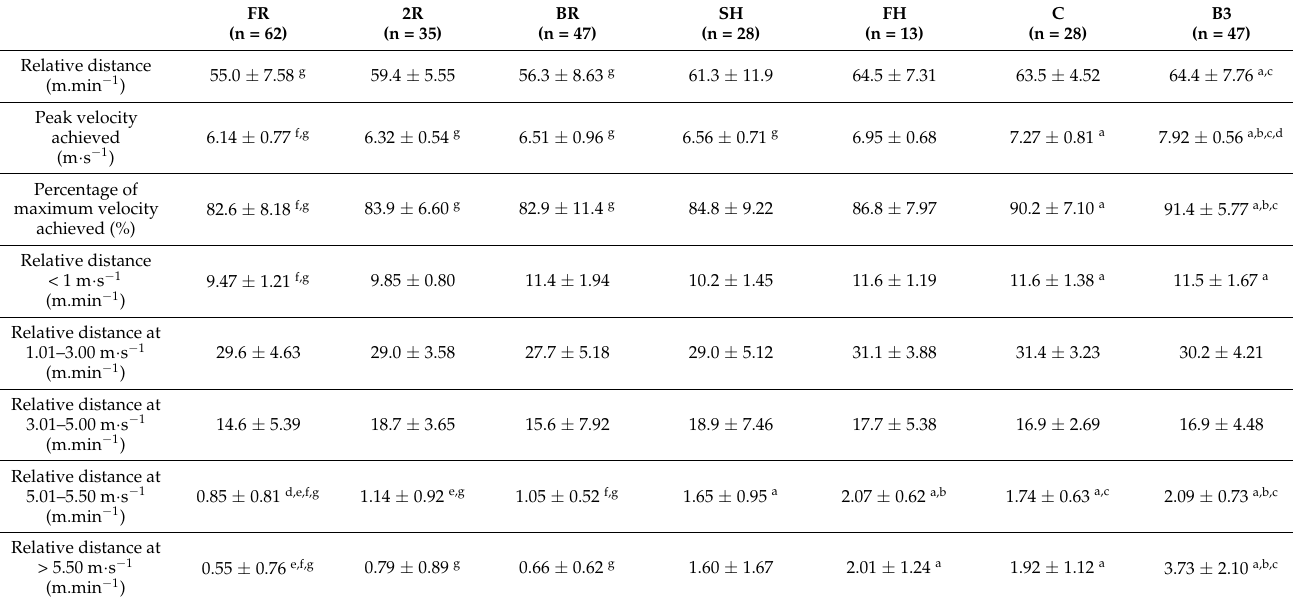
Table 3. Positional differences with pairwise comparisons in the relative physical match demands of match play for a squad of international female rugby union players during three consecutive years of the Women’s Six Nations